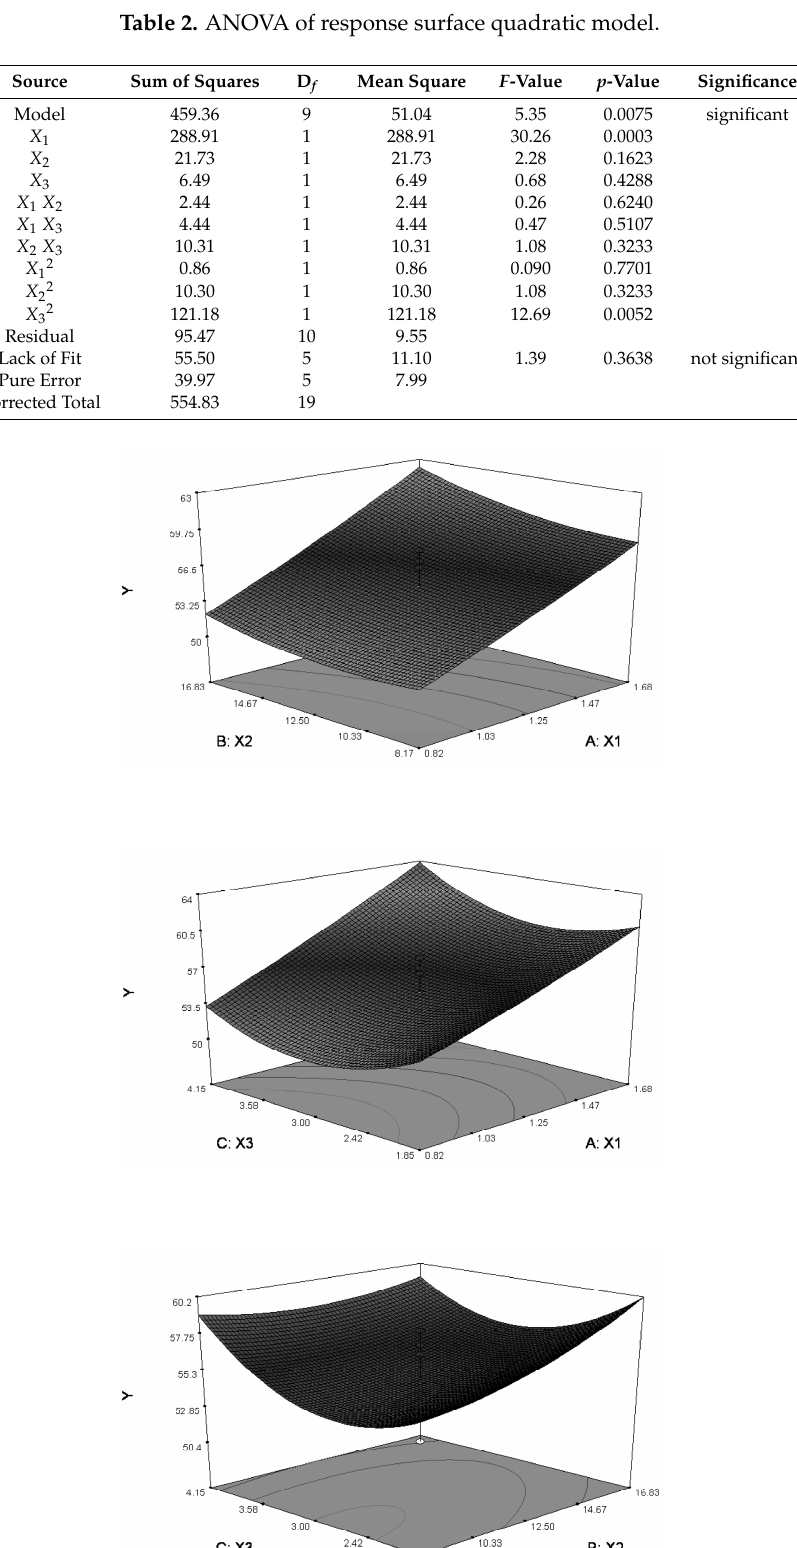
Table 2. ANOVA of response surface quadratic model.